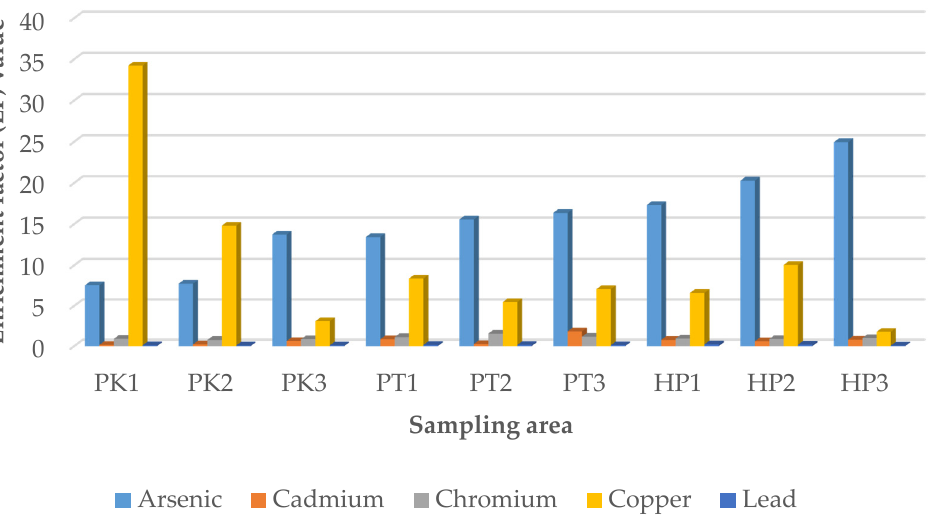
Figure 1. Enrichment factor (EF) from the soil to paddy grain of in the three studied areas. P1K, Plot 1 Kerian; P2K, Plot 2 Kerian; P3K, Plot 3 Kerian; P1PT; Plot 1 Perak Tengah; P2PT, Plot 2 Perak Tengah; P3PT, Plot 3 Perak Tengah; P3PT, Plot 3 Perak Tengah; P1HP, Plot 1 Hilir Perak; P2HP, Plot 2 Hilir Perak; P3HP, Plot 3 Hilir